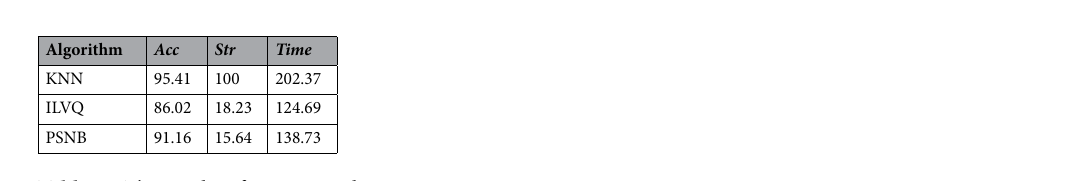
Table 6. The results of incremental